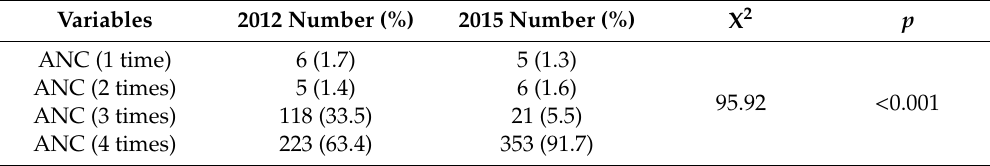
Table 2. Distribution of antenatal care service in 2012 and 2015 ( N = 576).